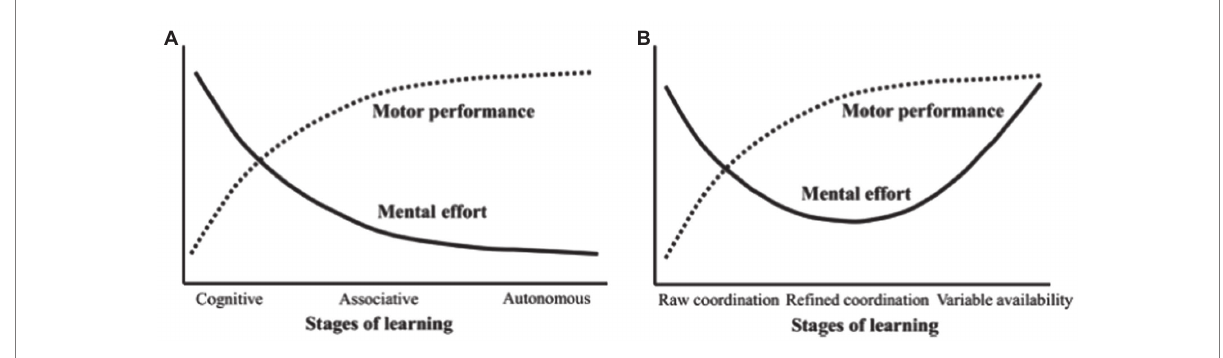
FIGURE 2 ( A and B ) Stages of motor skill acquisition and hypothesized cognitive